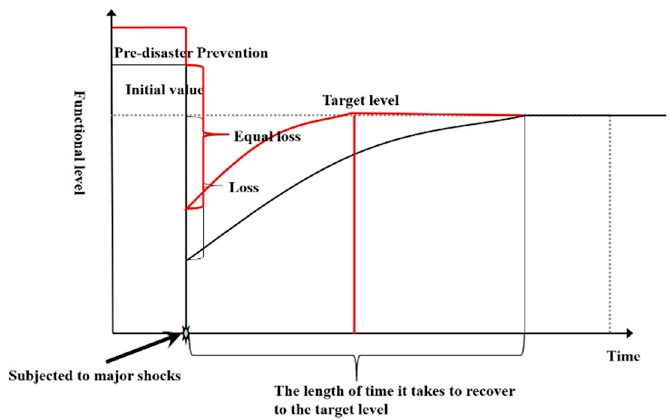
Figure 2. Contrast chart of city safety resilience curve before and after disaster prevention.